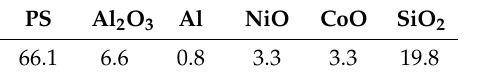
Table 3. Chemical composition (wt %) of the slurry